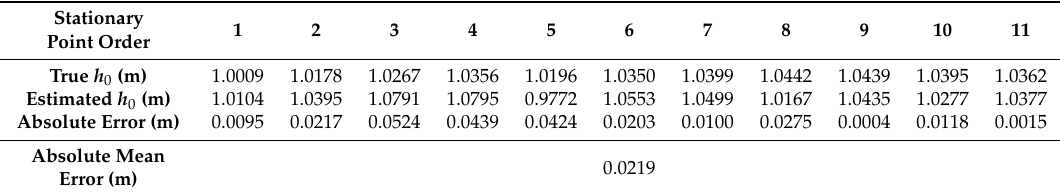
Table 5. Estimated and true h 0 at stationary points.